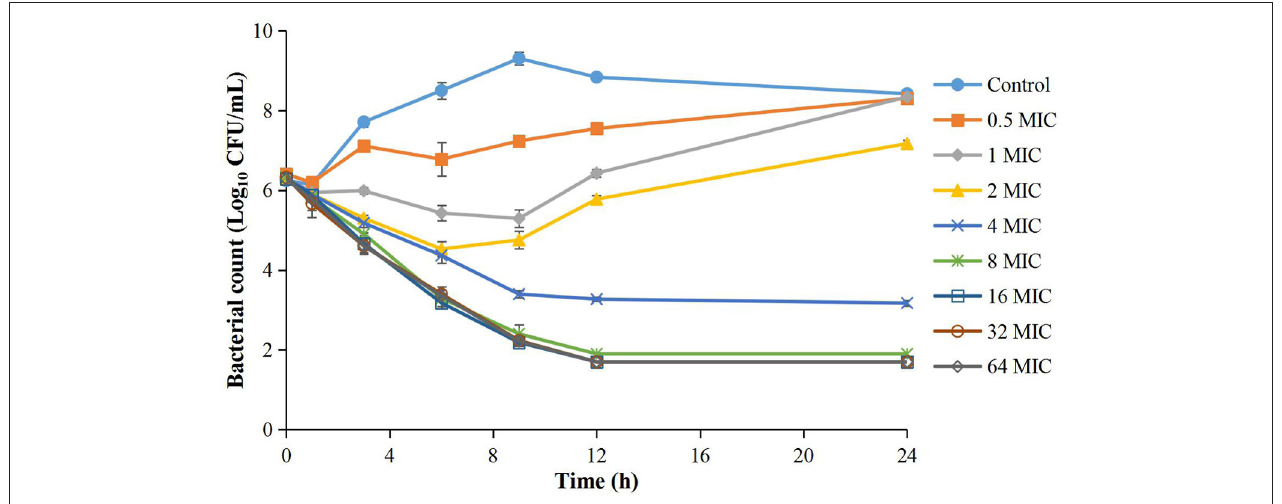
FIGURE 1 | Time-kill curves of different concentrations of cefquinome against A. pleuropneumoniae in TSB. Each symbol represents the mean ± SD after the experiment had been repeated thrice.